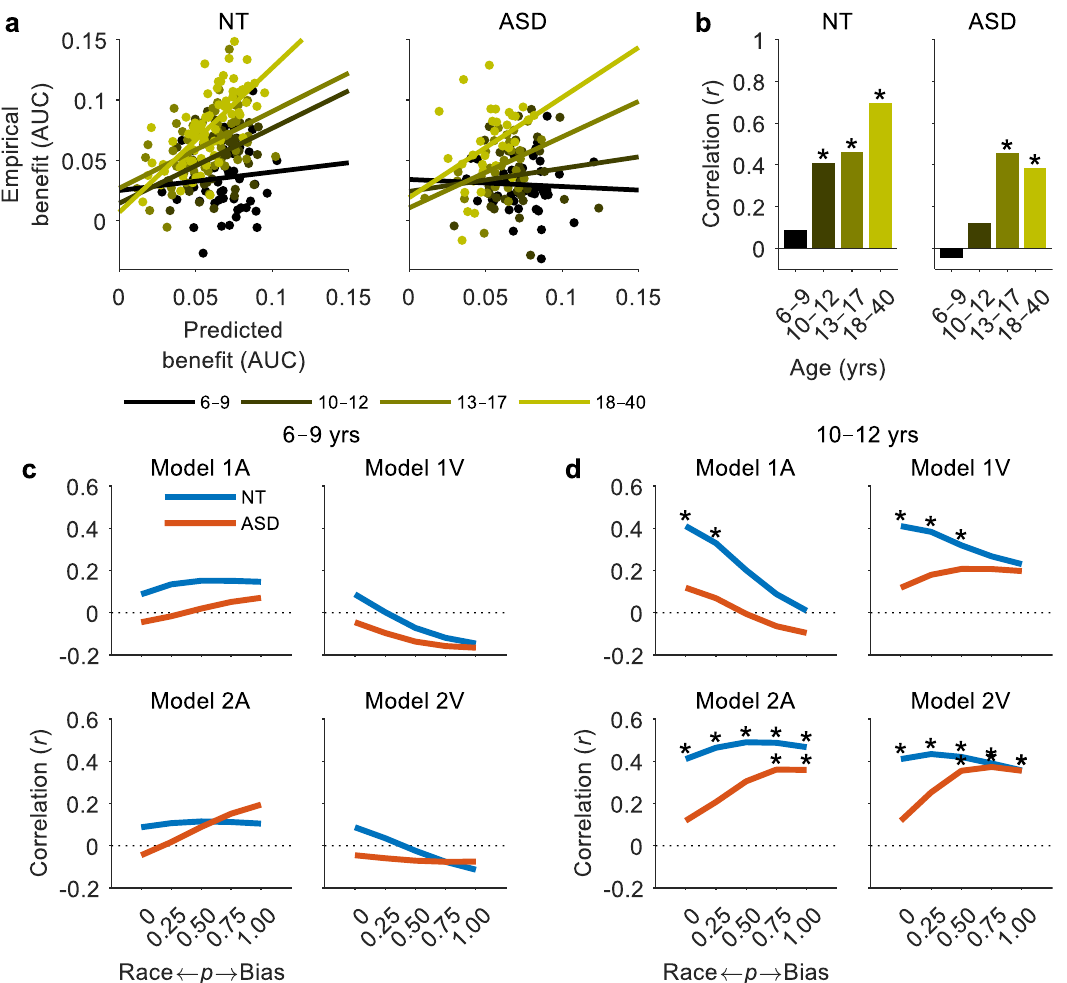
Fig. 4 Modelling multisensory behaviour. a Predicted bene fi ts versus empirical bene fi ts for NT (left panel) and ASD (right panel) participants. Each datapoint represents the AUC of an individual participant and age group is indicated by colour. Solid lines represent linear fi ts to the data by age group. b Pearson correlation coef fi cient ( r ) of the regression fi ts in a . Asterisks indicate signi fi cant correlations ( p < 0.05, two-tailed permutation tests). c , d Hypothetical models of multisensory competition were tested. Model 1A was biased towards the auditory modality and Model 1V towards the visual modality (Eq. 6). Model 2A was biased towards the preceding modality and the A modality when preceded by an AV trial, and Model 2V was biased towards the preceding modality and the V modality when preceded by an AV trial (Eq. 7). The probability p of multisensory processing being facilitative (race model) or competitive (bias model) was parametrically varied between 0 and 1 in increments of 0.25 (Eq. 8). The ability of the models to predict empirical bene fi ts was assessed within each age group based on the Pearson correlation coef fi cient. Data presented are the two younger age groups. See Supplementary Fig. 4 for the two older age